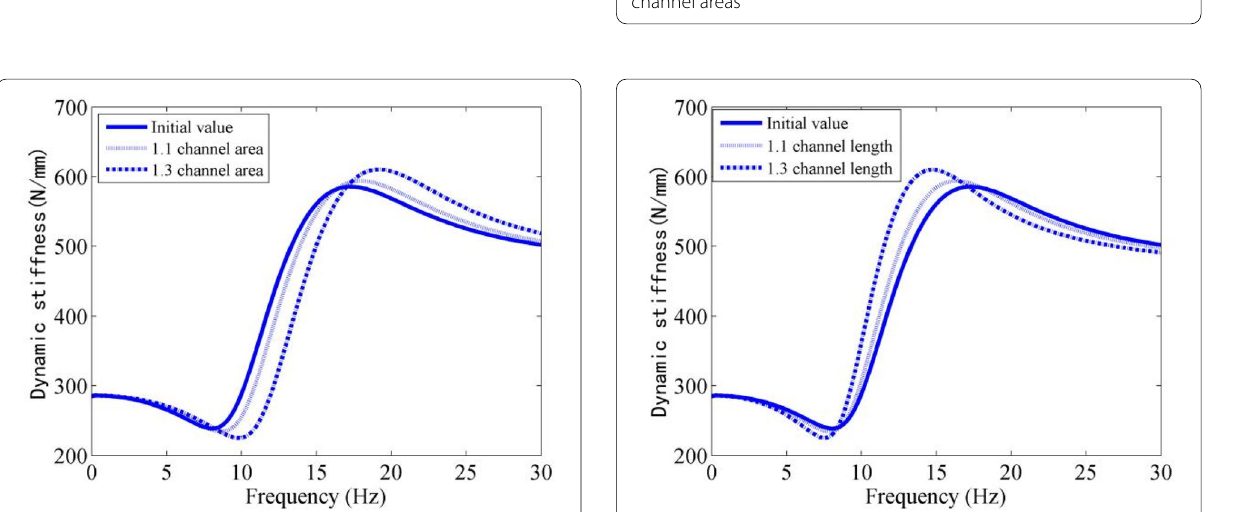
Figure 11 Loss angle vs. frequency curves in different piston areas